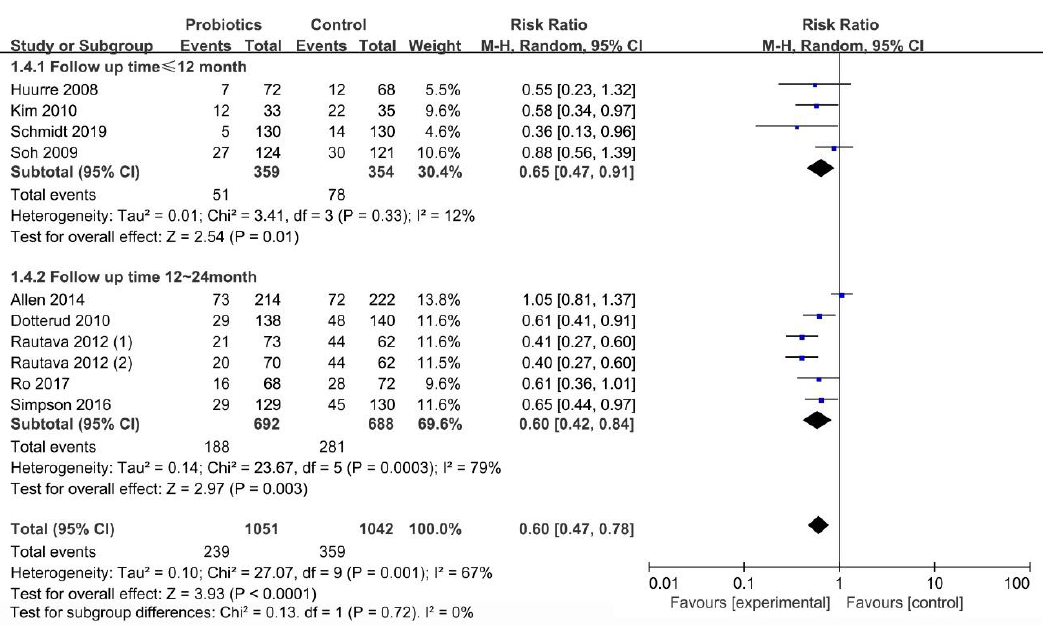
Figure 8. Forest plot of the association between mixed strains of Lactobacillus and Bifidobacterium and eczema at ≤12 months and 12–24 months of age.